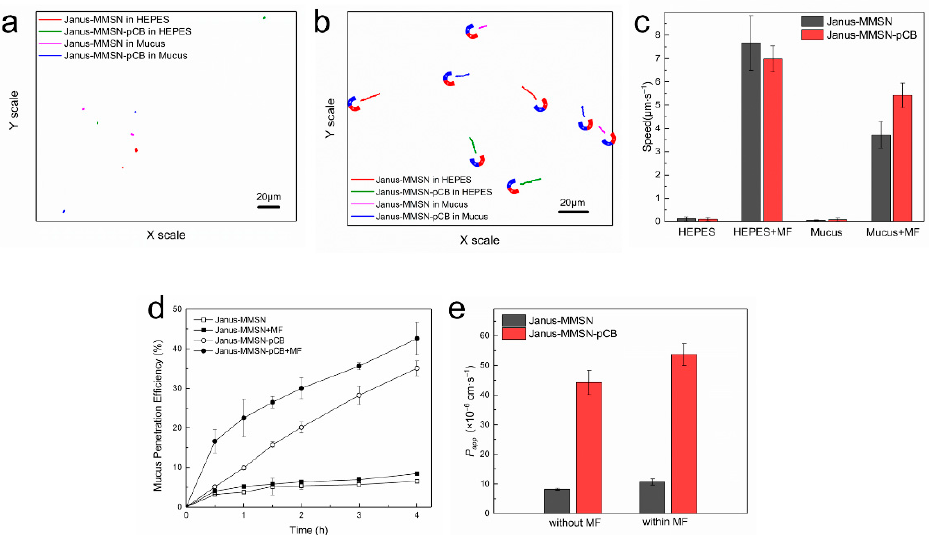
Figure 3. Mucus permeation analysis of Janus-MMSN and Janus-MMSN-pCB. Trajectories of Janus- MMSN and Janus-MMSN-pCB in HEPES (pH 7.4) and simulated mucus, without ( a ) or within ( b ) magnetic fields (t = 3 s, with a magnetic field strength of 20 mT and a gradient of 2 T/m). The average speed ( c ) of Janus-MMSN and Janus-MMSN-pCB in HEPES (pH 7.4) and simulated mucus. Permeation efficiency ( d ) and apparent permeability coefficient (P app ) ( e ) of Janus-MMSN and Janus- MMSN-pCB penetrating mucus in a Transwell ® system.